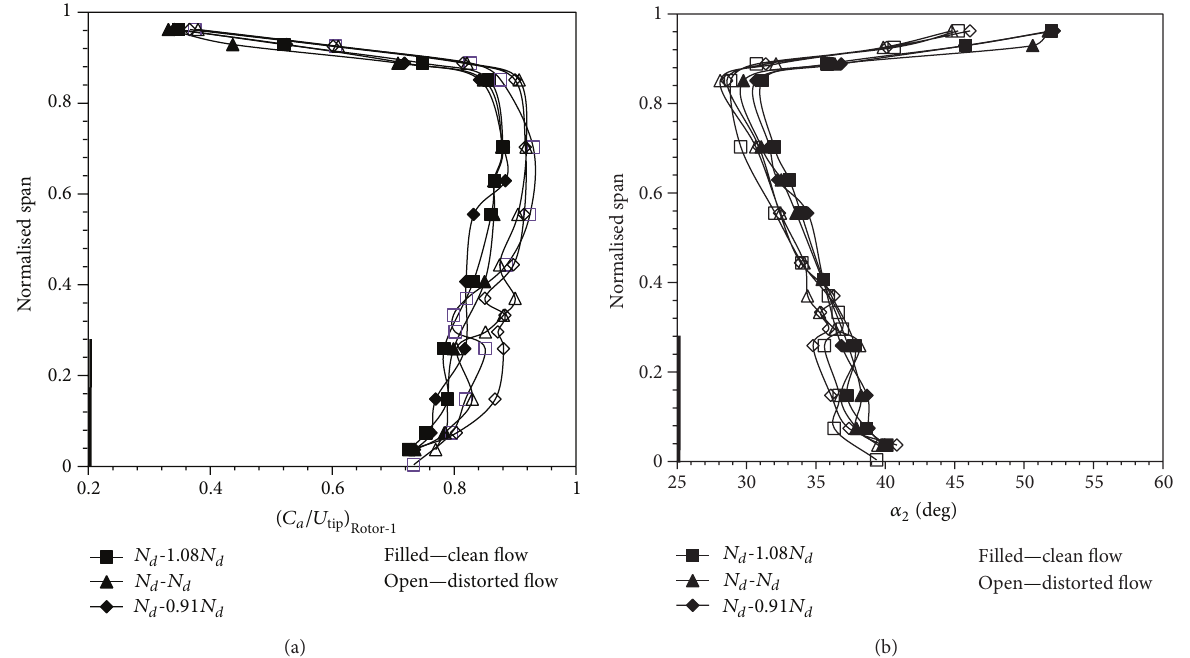
Figure 6: Spanwise variation of (a) axial velocity ratio and (b) flow angle at exit of rotor-1.